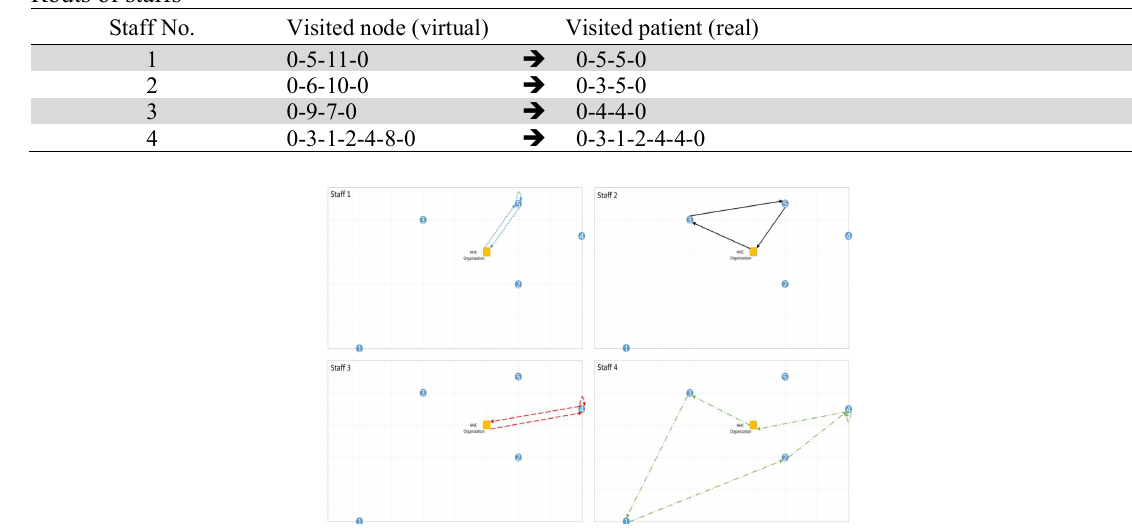
Routs of staffs Staff No.